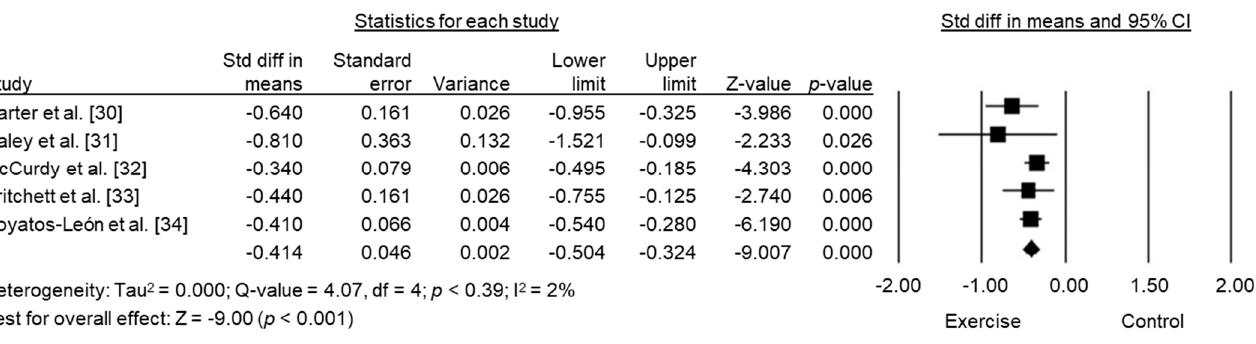
Figure 3. Forest plot of the standard mean differences of exercise intervention on postpartum depressive symptoms by the included meta-analyses.